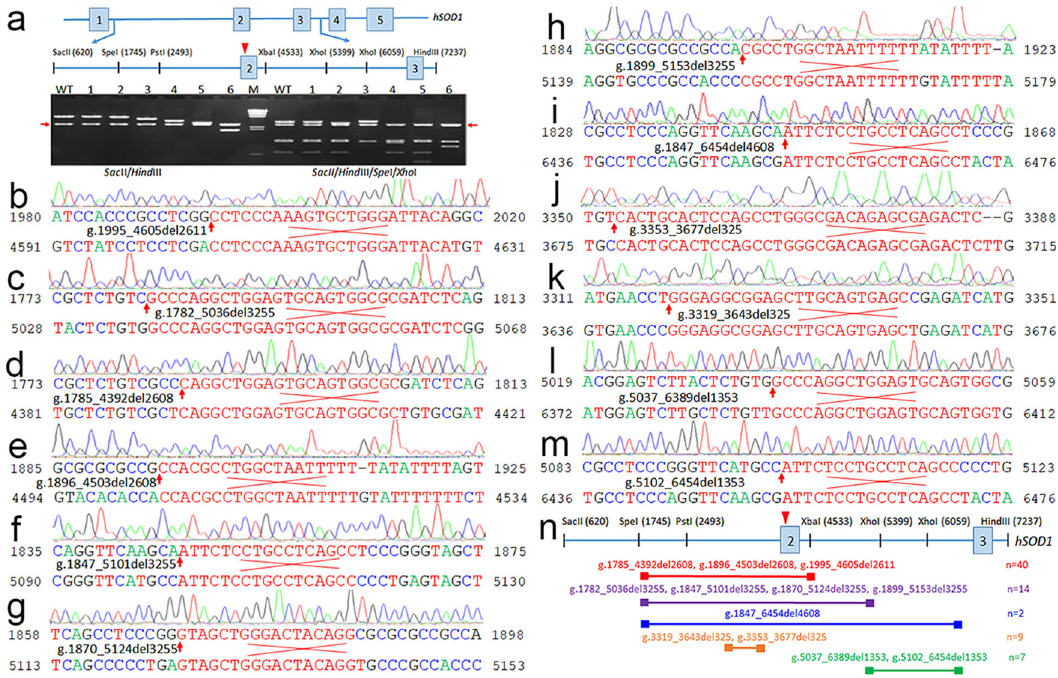
Fig. 5 PIS-mediated large deletions. a Schematic representation of the cloning and enzymatic analysis of a 6.6 kb fragment from hSOD1 in G1H/Cas9 mice. The restriction enzyme sites used for analysis are labeled. Red arrowhead indicates the Cas9 cleavage site. Red arrows indicate plasmid vector DNA. Six types of clones were identi fi ed. Type 1 was Wt-like, the other fi ve types showed smaller inserts. b – m Twelve deletions were identi fi ed, ranging from 325 to 4608 bp in size. Sequencing chromatogram of the DNA sequence around the junction is shown on the top. The PIS is color coded in red. The 5 ’ junction site is indicated by an arrow. Description of the deletions is based on the NCBI reference sequence (NC_000021.9) for human SOD1 . n Schematic representation of deletions showing the sizes and locations (diagrams are not drawn to scale for clarity). Six Alu elements are shown by fi lled boxes, and the deleted regions are shown by lines. Deletions mediated by different PIS in the same Alu elements are shown on the top of the lines. The total number of deletions are summarized on the right, and detailed in Table 1.